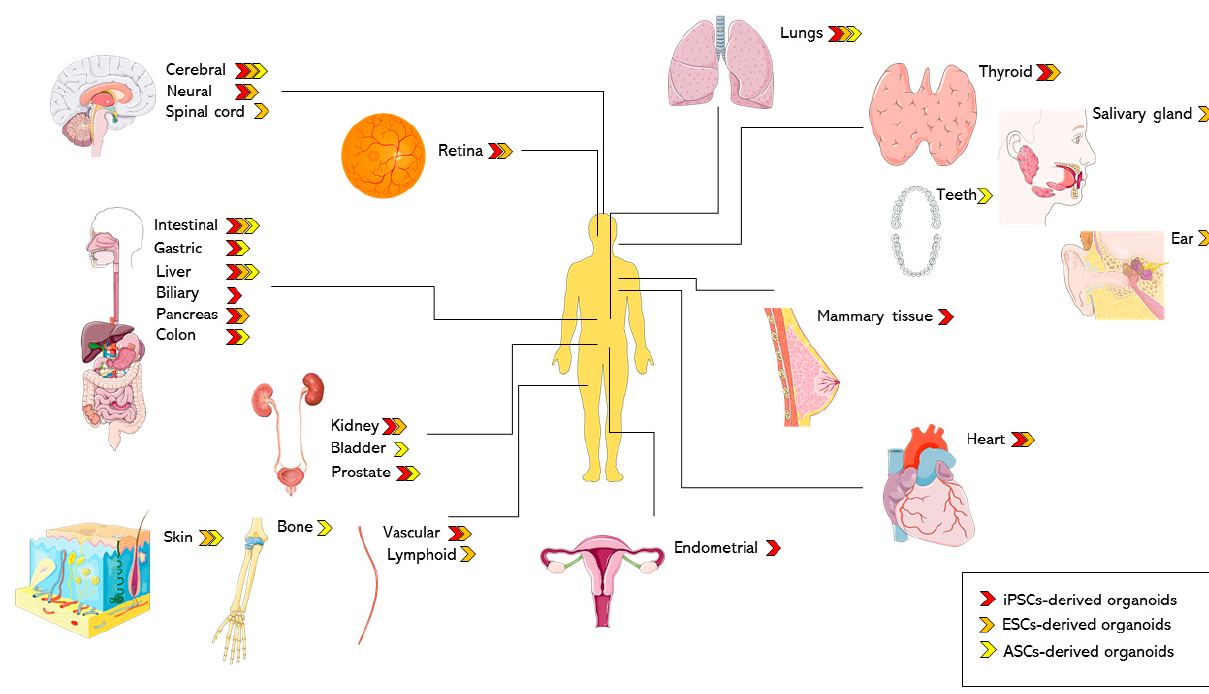
Figure 3. Reported organoid systems based on tissue of origin. Using different types of stem cells, many organs and tissues have been simulated using the organoids technology. Organ and human model images are imported from Servier Medical Art by Servier (http://smart.servier.com/), accessed on 24 May 2021. Licensed under a Creative Commons Attribution 3.0 Unported License (https://creativecommons.org/licenses/by/3.0/). Table 3. Table representing the multiple organ and disease models based on their respective organoid origin (iPSC, ESC and ASC). iPSC-Derived ESC-Derived ASC-Derived Organoids Organoids Organoids